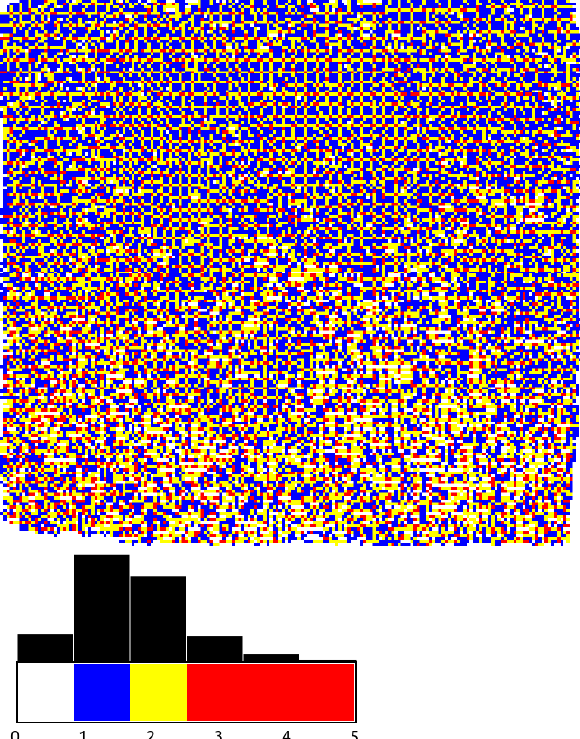
Figure 4: The number of points per cell for point cloud obtained using Kinect scanner (0.37 m × 0.35 m, raster resolution 0.002